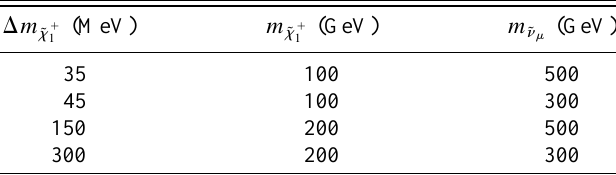
TABLE II. Achievable uncertainties with 50 fb 2 1 luminosity on the mass of the lighter chargino for representative m m ˜ n masses. From Ref. [80]. m